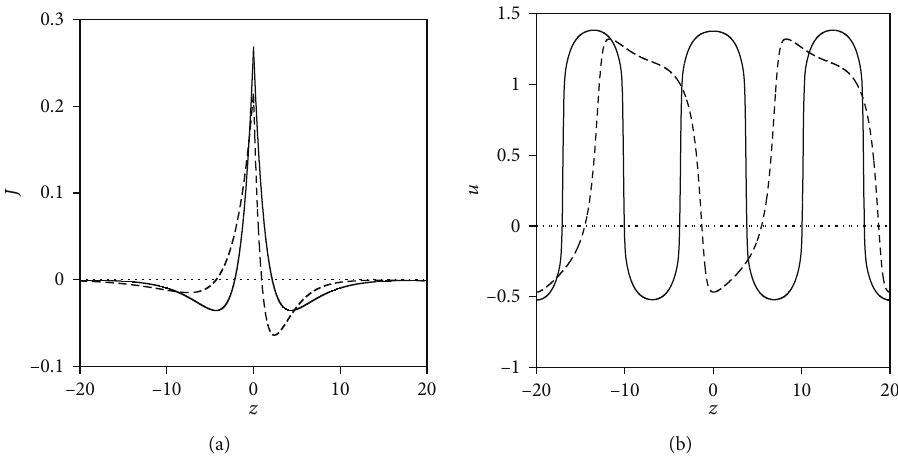
Figure 7: Pro fi les of the kernel given by Equation (16) and the stationary solution of the KT model (14) under periodic boundary = 2 and L = 2 0. Solid and dashed curves represent cases of c = 0 and 0.5, respectively. (a) Pro fi les of the kernel. (b) Pro fi les conditions. d 2 of the stationary solution.